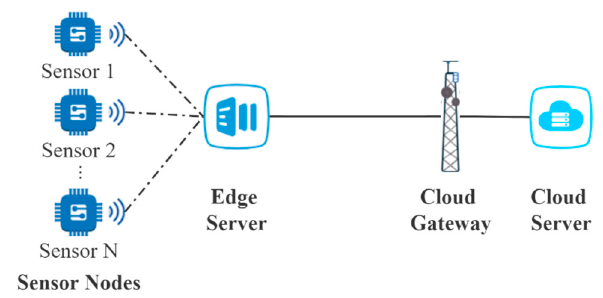
Figure 1. Architecture of the edge computing